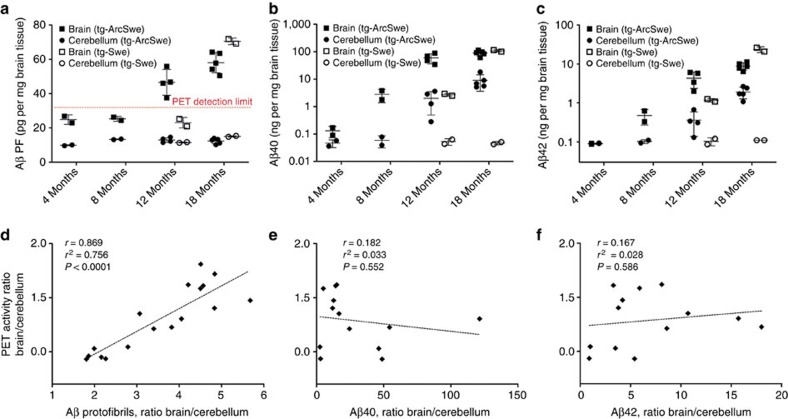
Aβ levels in brain and cerebellum and correlation with PET data.(a) Aβ protofibril (PF) levels in brain tissue obtained from tg-ArcSwe (n=13) and tg-Swe (n=4) mice of different ages; total Aβ40 (b) and Aβ42 (c) levels in brain and cerebellum from tg-ArcSwe and tg-Swe mice of different ages; Pearson's correlation analysis of brain/cerebellum PET ratio and brain/cerebellum concentration ratio of soluble Aβ protofibrils in tg-ArcSwe and tg-Swe mice (d) and of total Aβ40 (e) and Aβ42 (f) in tg-ArcSwe mice. Each symbol represents one animal previously subjected to PET scanning; the line and error bars (a–c) indicate group mean±s.d.